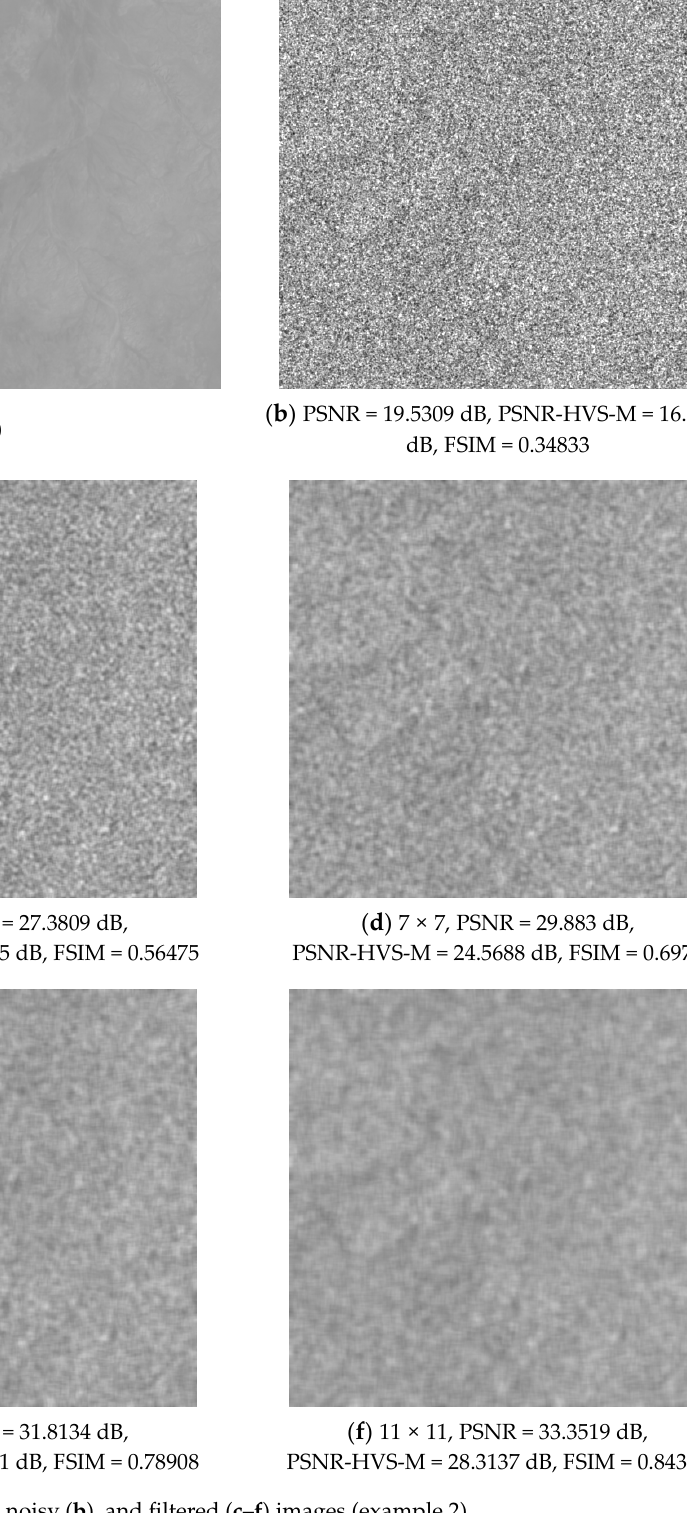
Figure 3. Noise-free ( a ), noisy ( b ), and filtered ( c – f ) images (example 2).